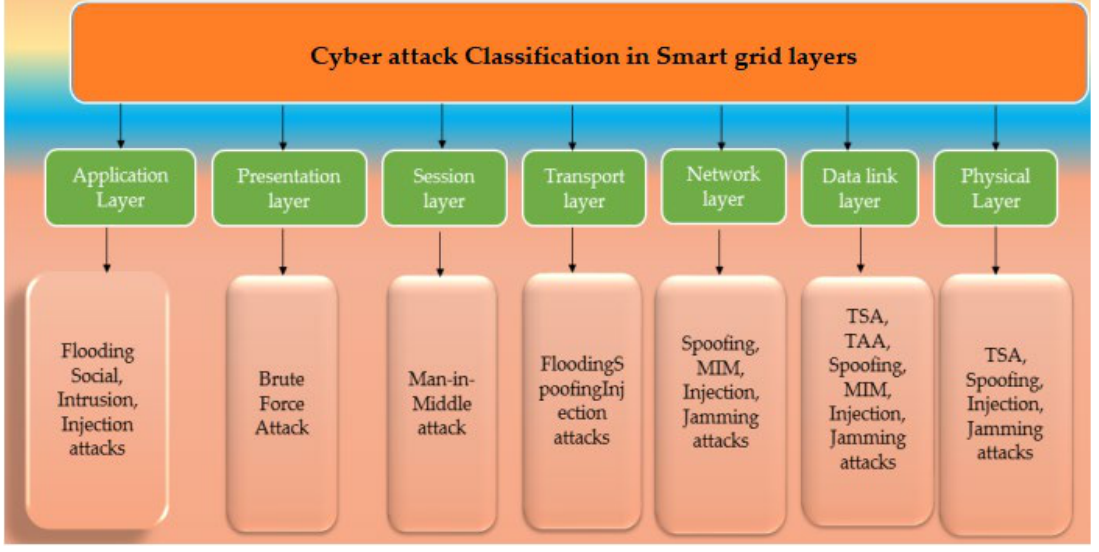
Figure 6. Cyber-Attack Classification Based on Communication Layers [10].